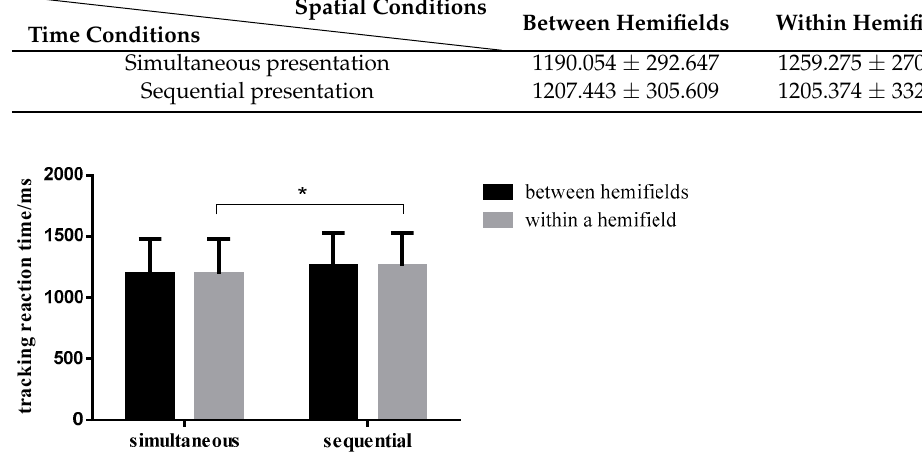
Figure 6. Comparison of tracing reaction time of different presentation conditions under simultaneous and sequential conditions. Note: * indicates the significance level is p < 0.05.